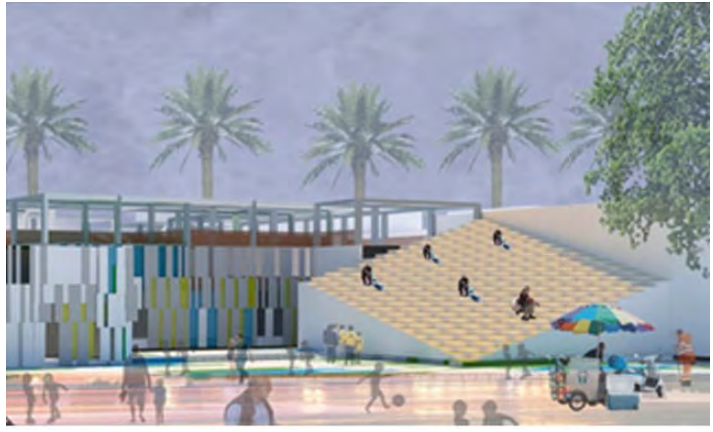
Figure 11. Showing plaza (“Ahmed Shemisah’s”